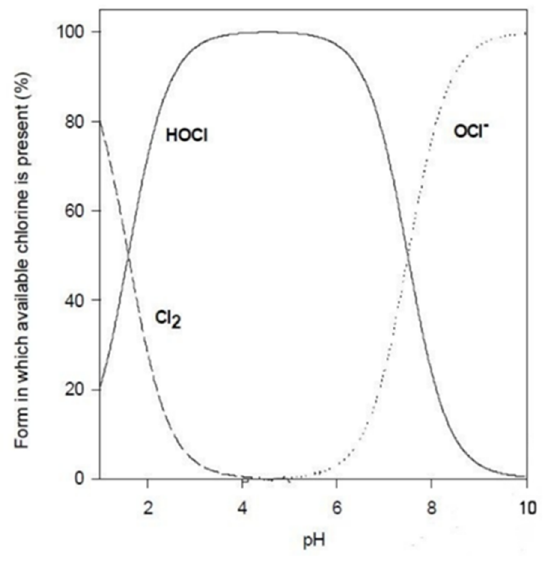
Figure 6. Active chlorine species concentration at different pH values [42].